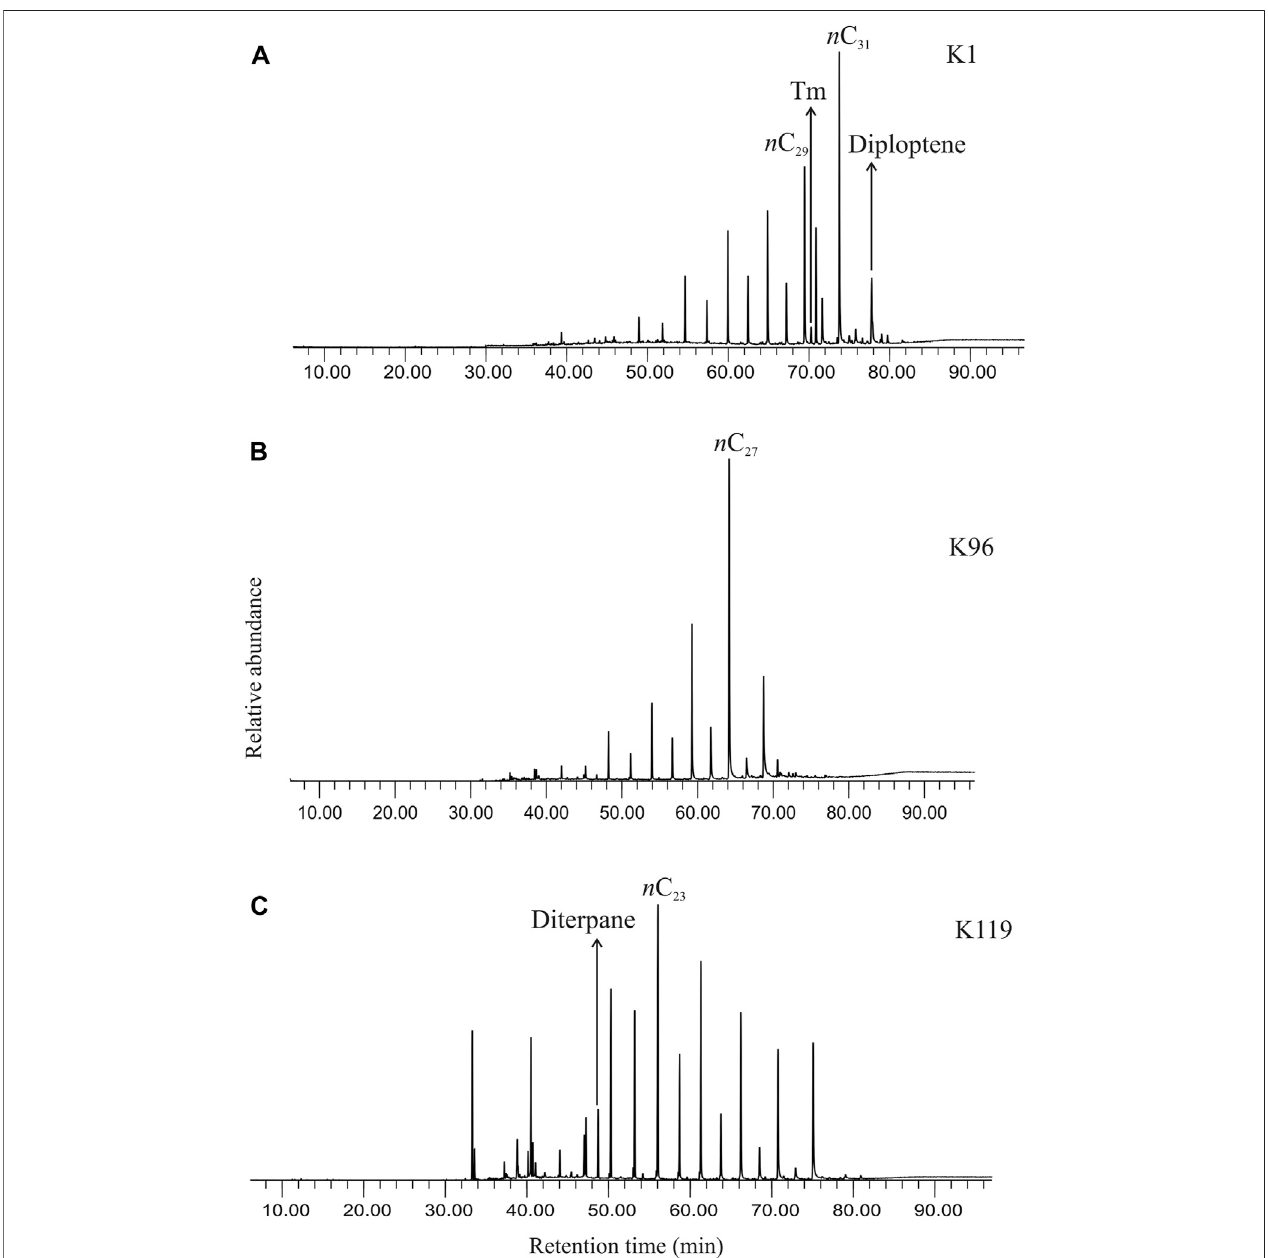
FIGURE 2 | (A) Total ion chromatogram showing the distribution of biomarkers, both linear chain and cyclic compounds, in the saturated hydrocarbon fraction extractedfromthestudiedsediment(K1, ∼ 369 cal yrBP). (B) Totalionchromatogramshowingthedistributionofbiomarkers,bothlinearchainandcycliccompounds,in the saturated hydrocarbon fraction extracted from the studied sediment (K96, ∼ 4842 cal yr BP). (C) Total ion chromatogram showing the distribution of biomarkers, both linear chain and cyclic compounds, in the saturated hydrocarbon fraction extracted from the studied sediment (K119, ∼ 5655 cal yr BP).